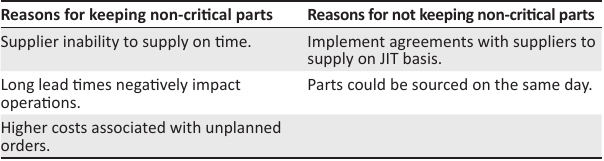
FIGURE 4: Material planning system used by the cement TABLE 3: Stock keeping of non-critical parts.